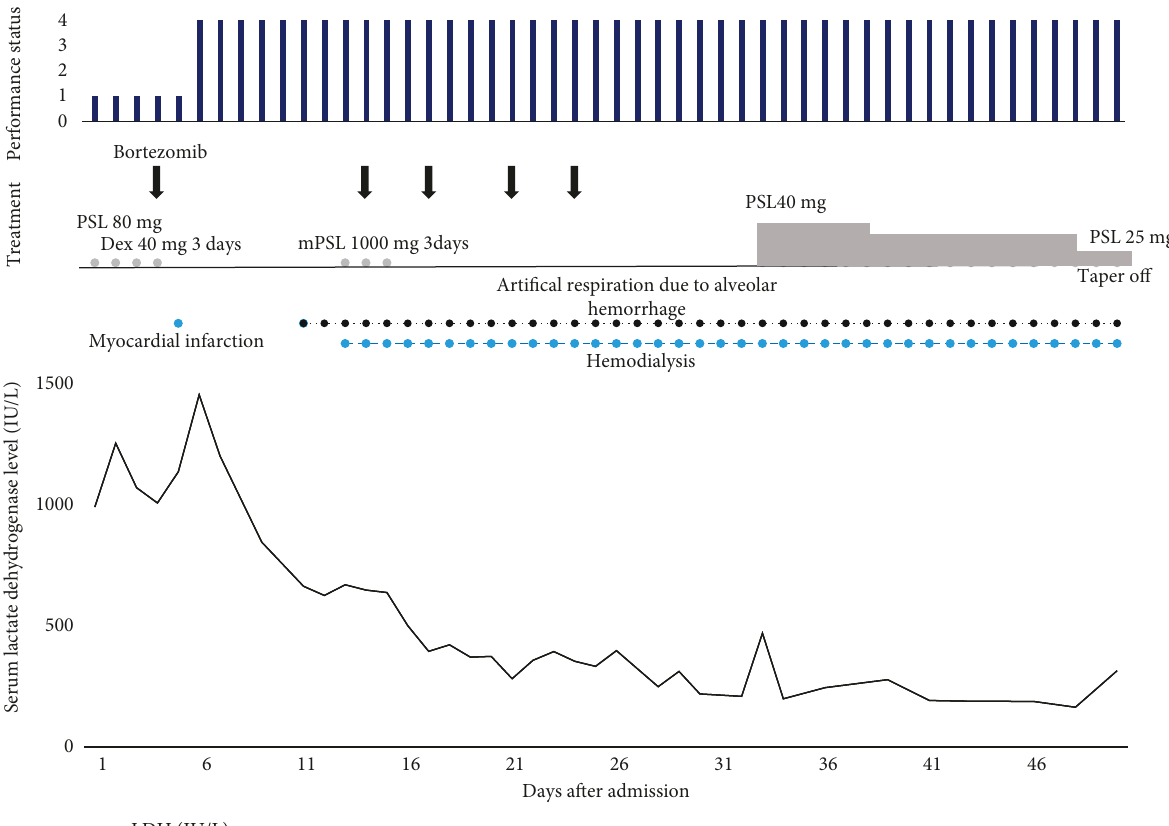
Figure 1: Clinical course after admission to our hospital. After bortezomib administration, the serum lactate dehydrogenase level decreased. LDH; lactate dehydrogenase. PSL; prednisolone, Dex:dexamethasone, and mPSL;